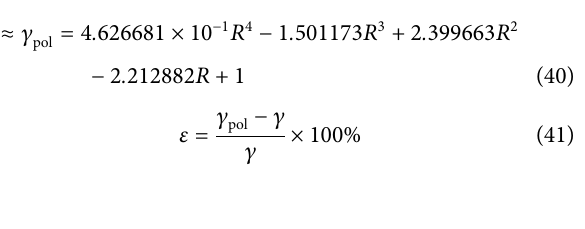
(original pressure, temperature, and gas properties) while independent of the production conditions.